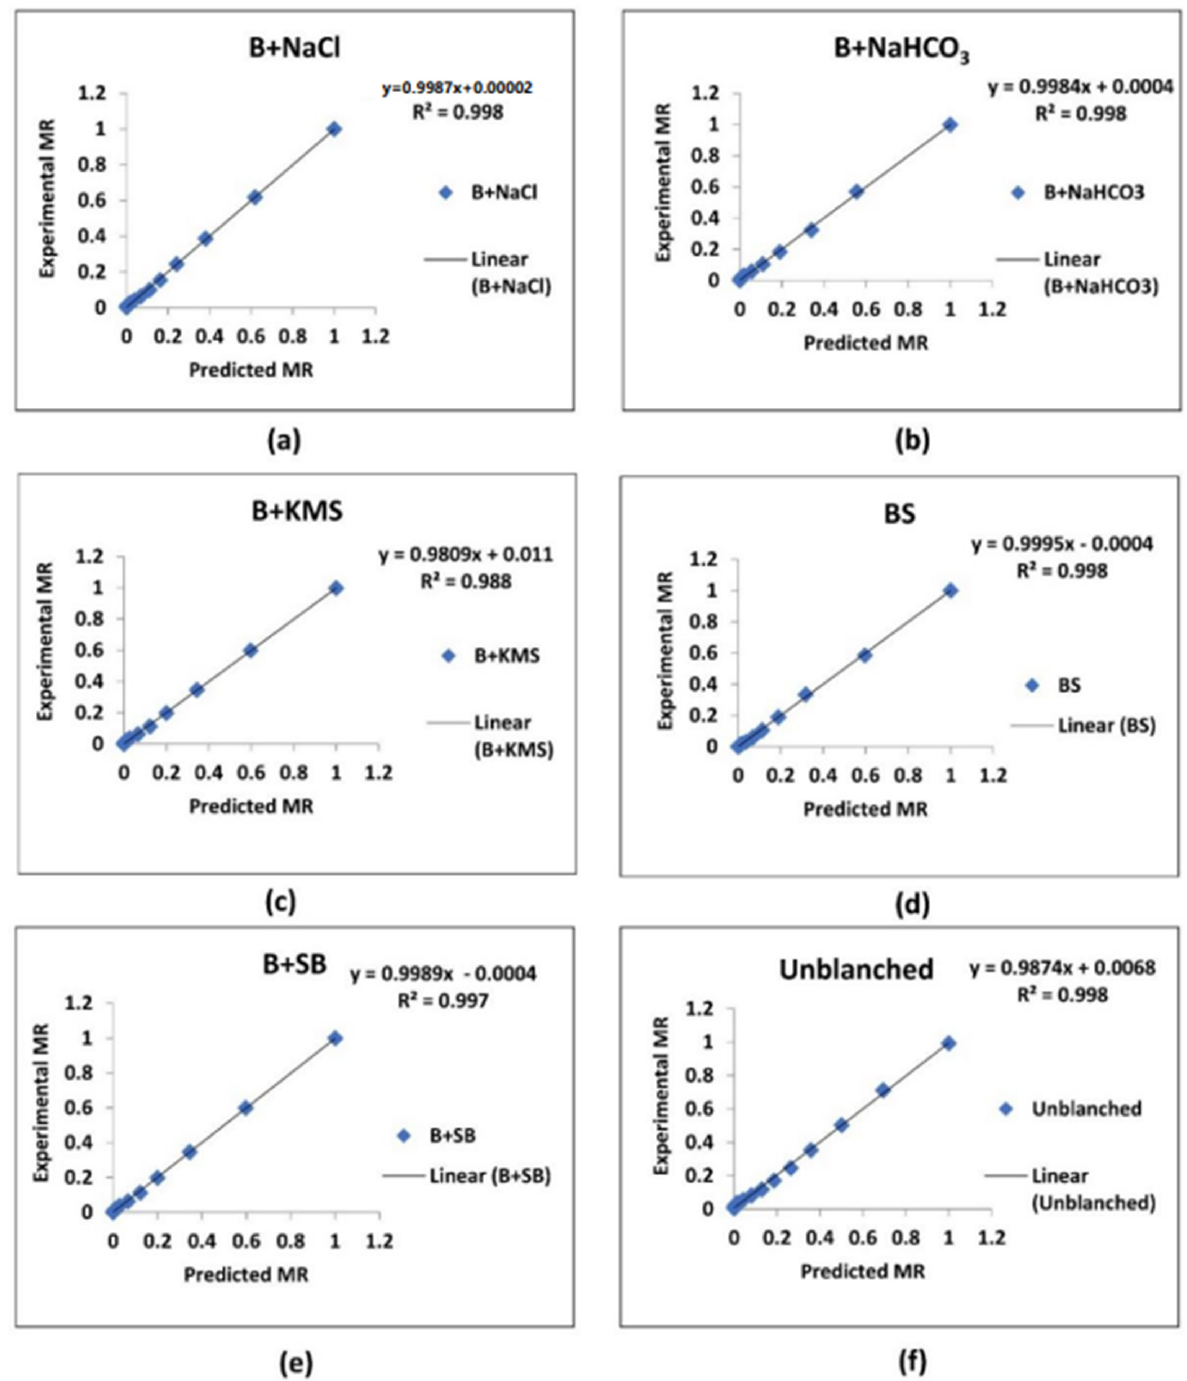
Figure 4. ( a – f ): Plot of experimental moisture ratio against predicted moisture ratio of pretreated and unblanched Moringa leaves at 60 ° C using Midilli–Kucuk model for fluidized bed drying.